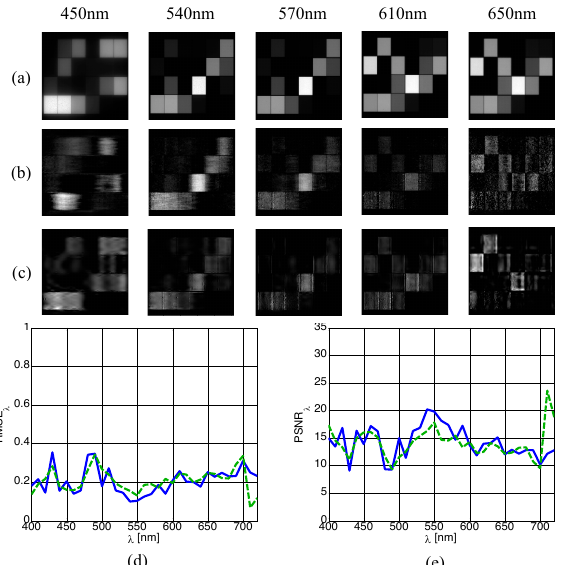
Figure 4. Five out of 33 monochromatic “Color Checker” images extracted from the spectral cubes at wavelengths 450nm, 540nm, 570nm, 610nm and 650nm: (a) reference measured with spectral filters; (b) reconstructed images using the 2D framelet and (c) 3D wavelet methods, respectively. (d) RMSE λ and (e) PSNR λ values as functions of wavelength for the monochromatic images that were CS reconstructed using the 2D framelet method (blue) and 3D wavelet method (dashed green). Figures 5 and 6 show reference and reconstructed spectra and RGB values, respectively, at eight spatial sampling points, marked by the same numbers as in Figure 3(b).